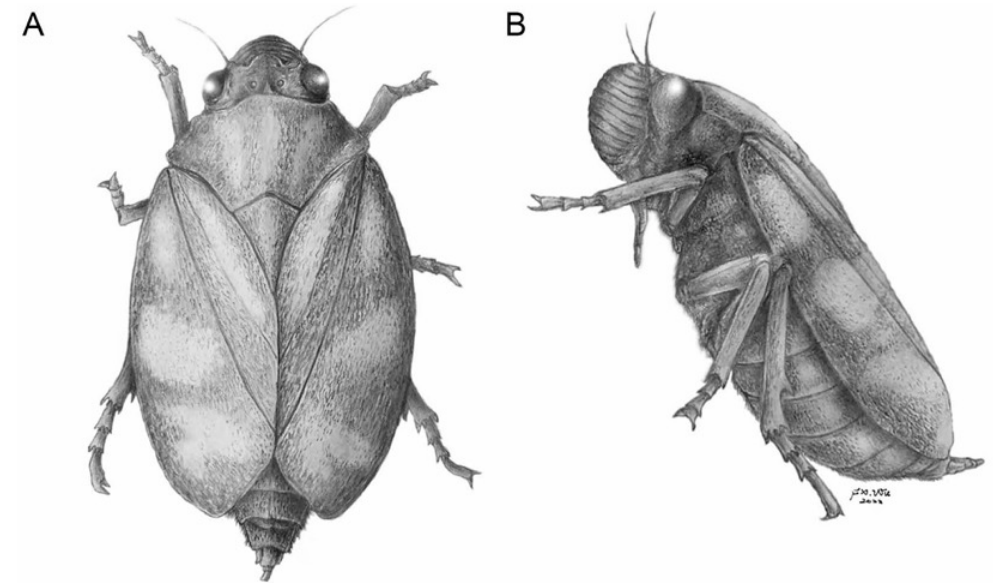
Figure 6. Reconstruction of Nangamostethos tibetense gen. et sp. nov. ( A ) Dorsal view. ( B ) Lateral view. Art by Fei-Xiang Wu.